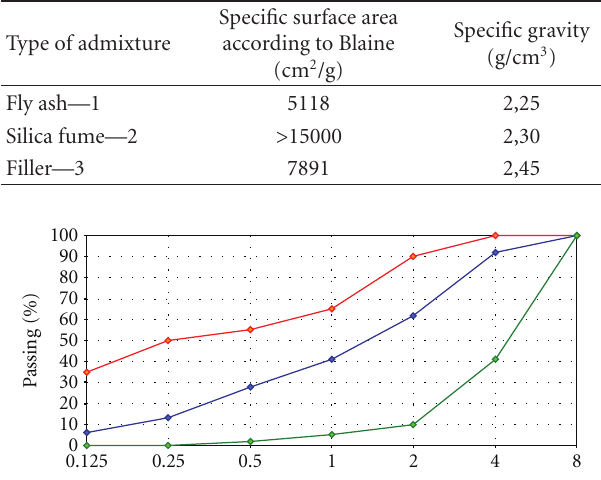
with a total of eight di ff erent mixture designs, were made. In all groups the same cement and superplasticizer were used, while other components were variable. The cement used was CEM I 42.5 R with a specific mass density of 3.14 kg/dm 3 and the superplasticizer was the liquid PCE (polycarboxylic acid ether) with a specific density of 1,06 kg/dm 3 .